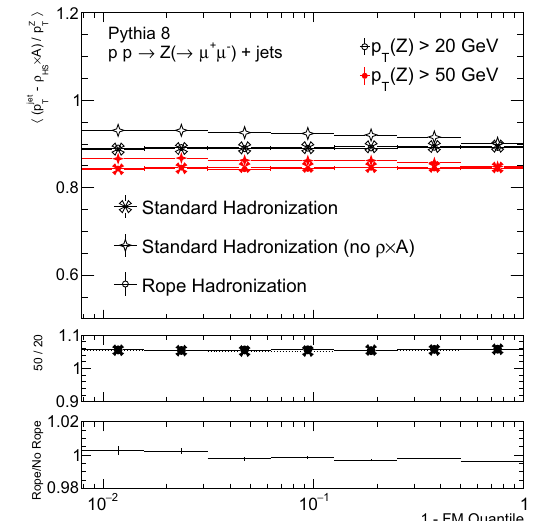
Fig. 9 The average fractional transverse momentum imbalance between leading jet and Z boson, x ZJ = p T , J / p T , Z , as a function of track multiplicity quantile, FM. Three curves in the upper panels indicate the values for the standard hadronization with and without an area correction as well as the rope hadronization with the correction. Higher multiplicities are to the left. The middle panel shows the ratio of the higher to lower Z boson p T cut (standard hadronization is shown